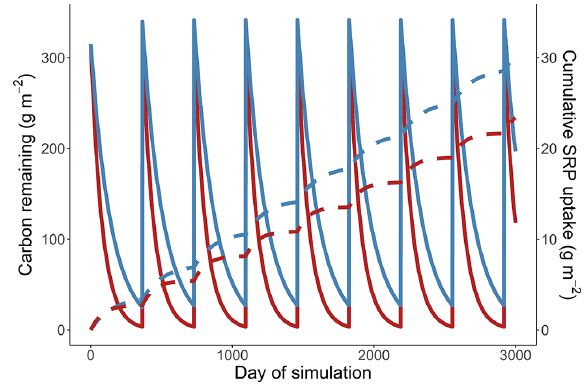
Figure B1. Simulation from a cold and warm scenario using a tem- perature dependence of respiration of 1.02eV, a temperature depen- dence of soluble reactive phosphorus uptake of 0.52eV, and a ref- erence rate of respiration increased to make the residence times of carbon more realistic. These simulations also have annual leaf in- puts which occur instantaneously, once every 365d, and are equiva- lent to the initial mass of leaves in the stream (315gCm − 2 ) . Mass of carbon (solid lines) and cumulative uptake of SRP (dashed lines) are presented over time for a 14 ◦ C (red) and 10 ◦ C (blue) tempera- ture